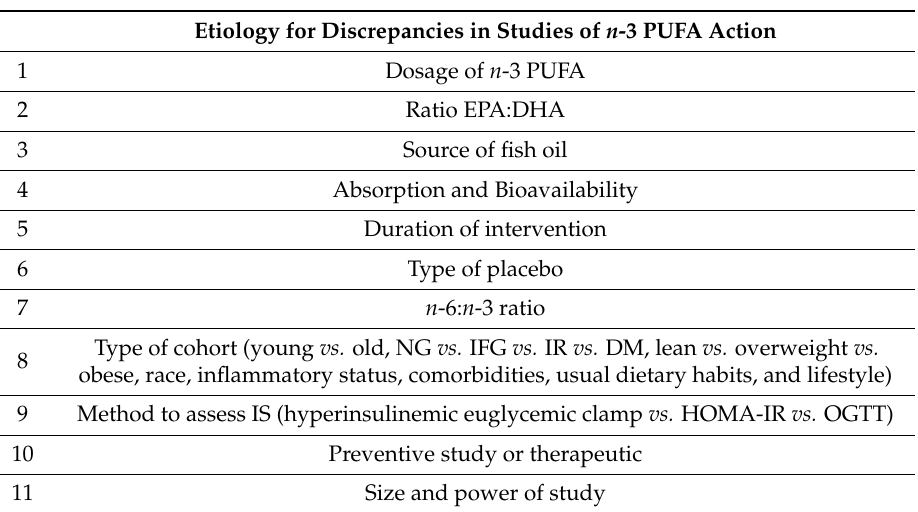
Table 2. Confounders in translating animal–human